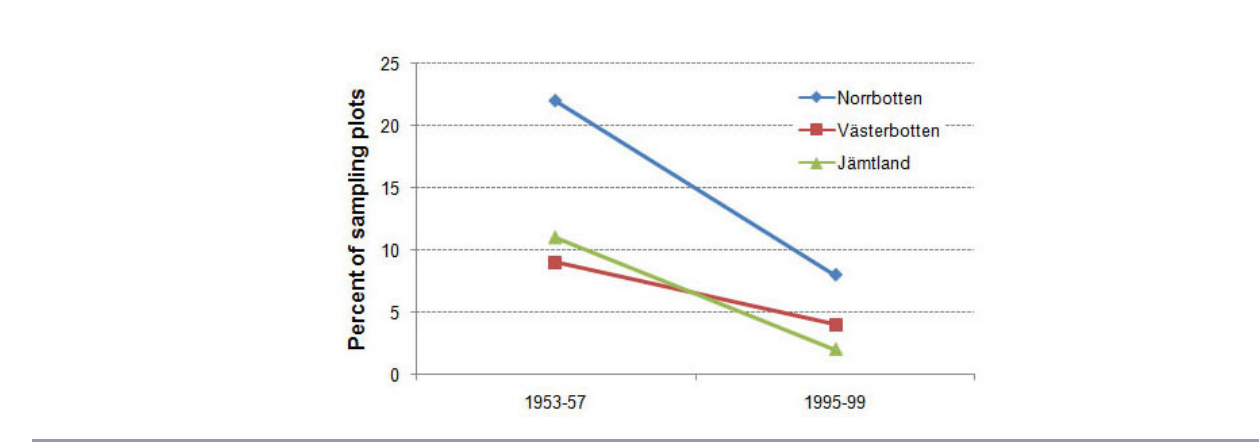
Fig. 4 . Percentage of sampling plots in the three northernmost counties in Sweden classified as lichen- type, i.e., containing >50% cover of lichens (Swedish National Forest Inventory data in SOU